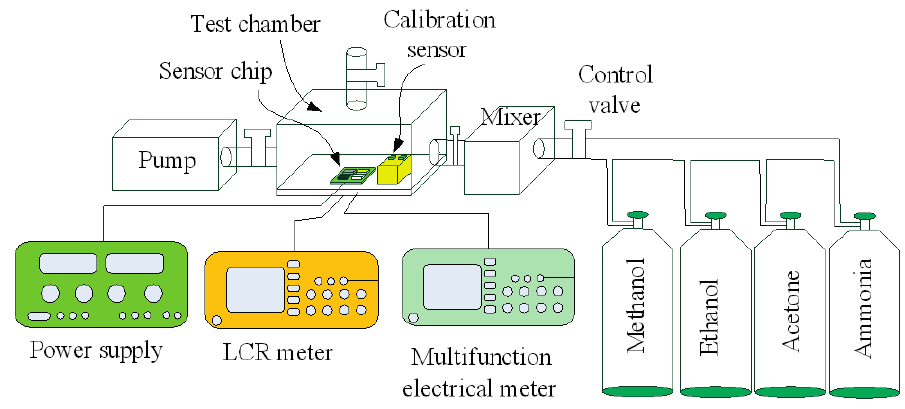
Figure 10. Measurement setup for the methanol sensor.